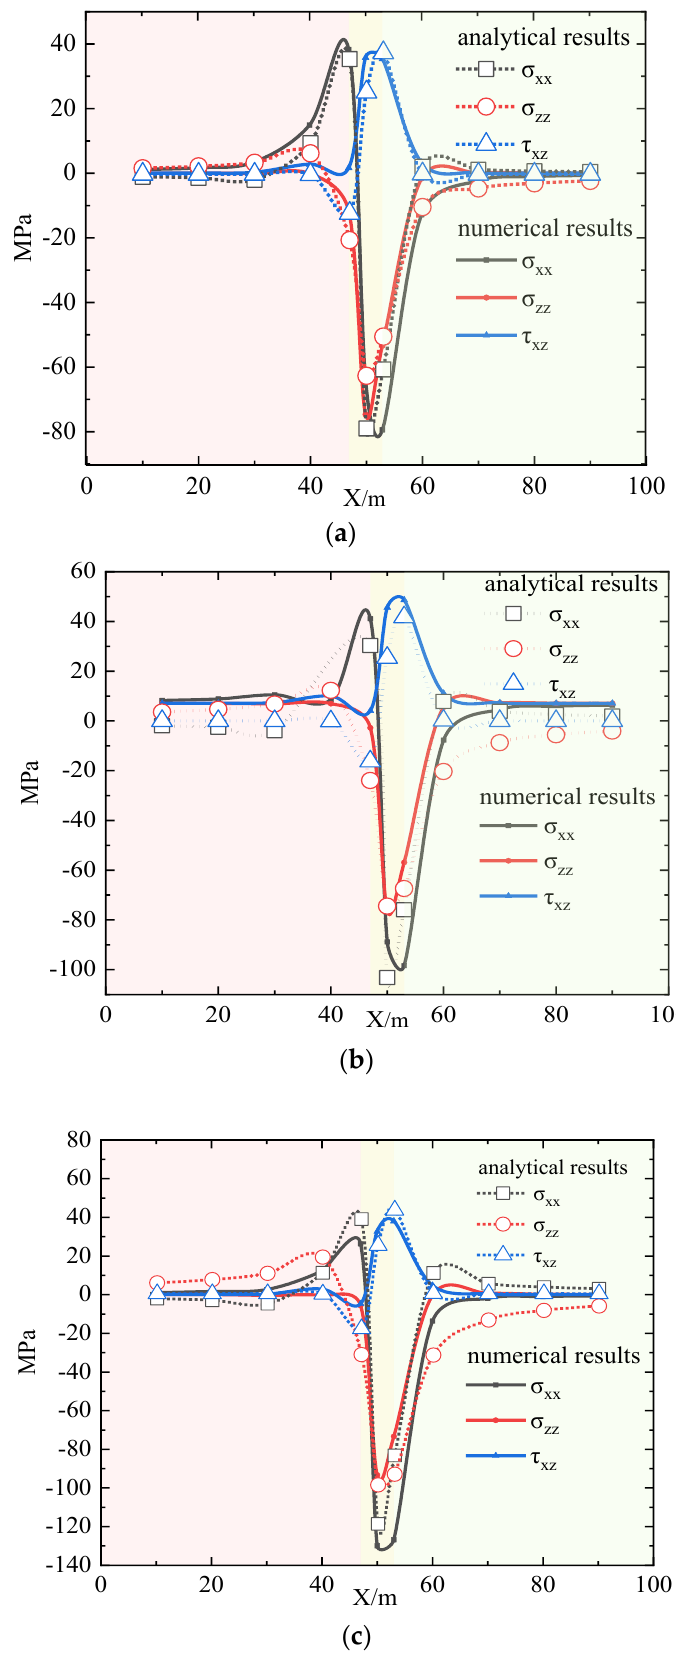
Figure 8. Comparisons between the proposed solution and numerical results for the values of E 1 /E 2 .